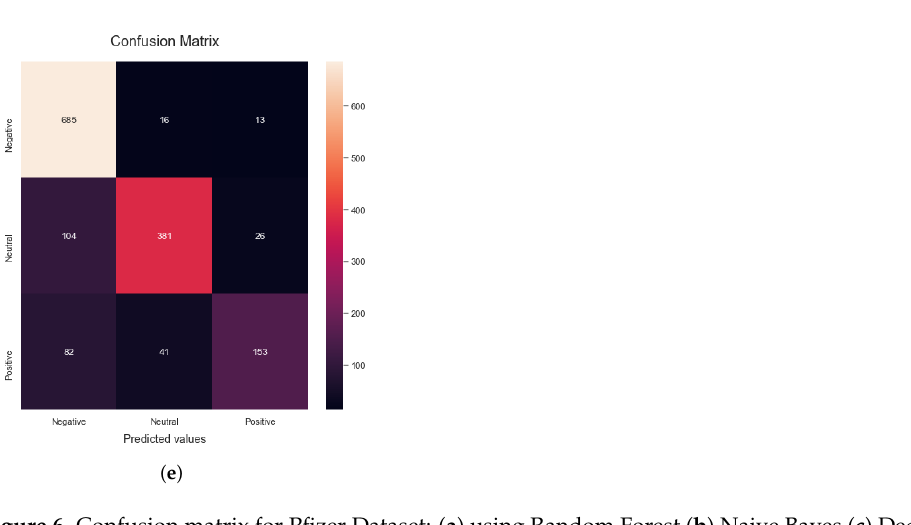
Figure 6. Confusion matrix for Pfizer Dataset: ( a ) using Random Forest ( b ) Naive Bayes ( c ) Decision Tree ( d ) Logistic Regression ( e ) SVM. Table 5. Machine learning performance on Pfizer vaccine